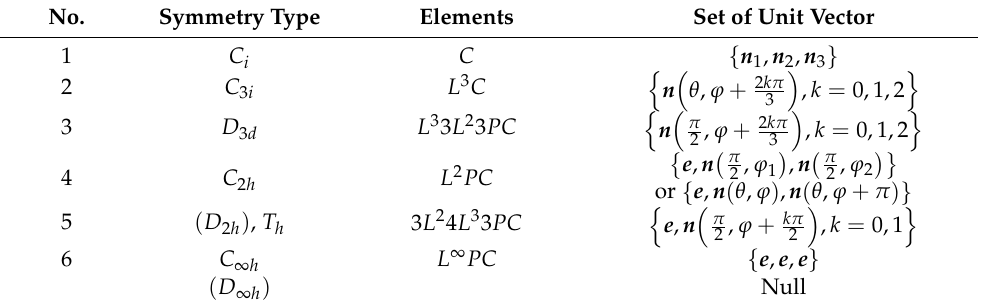
Table 3. Symmetry types and the unit vector sets of (cid:15) H ( 3 ) . Note (similarly hereinafter): the symmetry groups marked in red and inside parentheses degenerate or simply do not exist, Null means that there are no invariant unit vector sets under this point group. For simplicity, the principal axis of the point group is set to the e -axis).